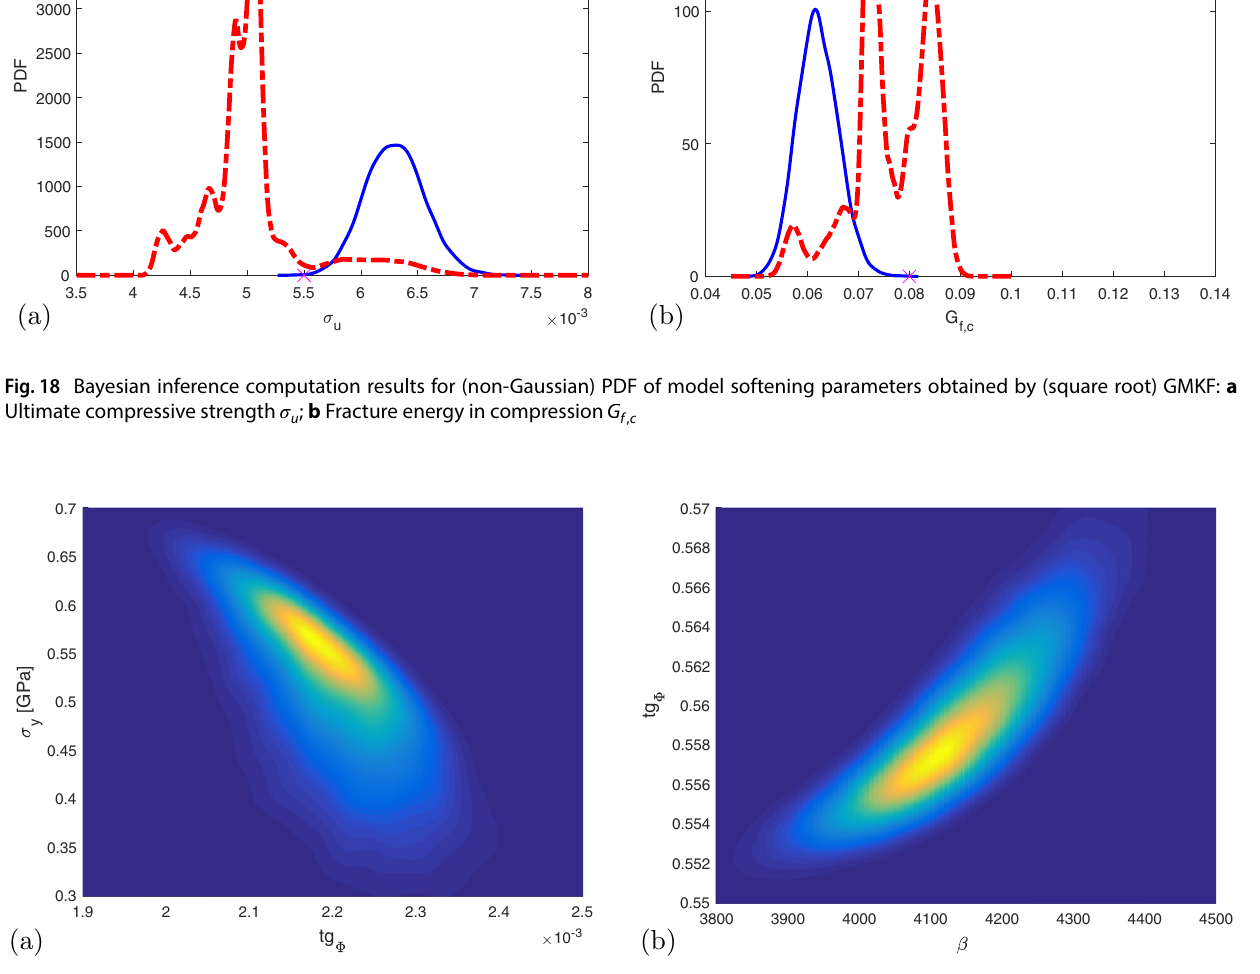
Fig. 17 Joint PDF for: a yield stress— 𝜎 y and angle of internal friction— tan ( 𝜙 ) ; b hardening parameter— 𝛽 and angle of internal dila- tancy— tan ( 𝜓 ) for a combined uniaxial and biaxial compression test